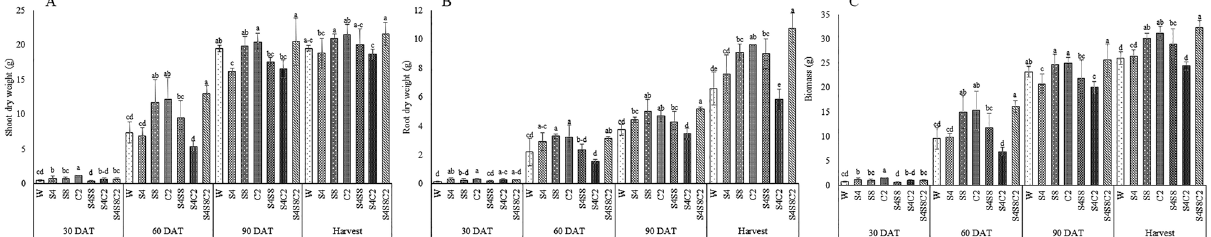
Figure 6. Effect of bacterial inoculation on shoot dry weight ( A ), root dry weight ( B ), and biomass ( C ). Different letters represent significant differences ( p < 0.05) according to the LSD test. W: uninoculated plant as control, S4: B. subtilis S42, S8 : E. cloacae S81, C2: P. azotoformans C2-114, S4S8: co-inoculation B. subtilis S42 and E. cloacae S81, S4C2: co-inoculation B. subtilis S42 and P. azotoformans C2-114, S4S8C2: mix of all